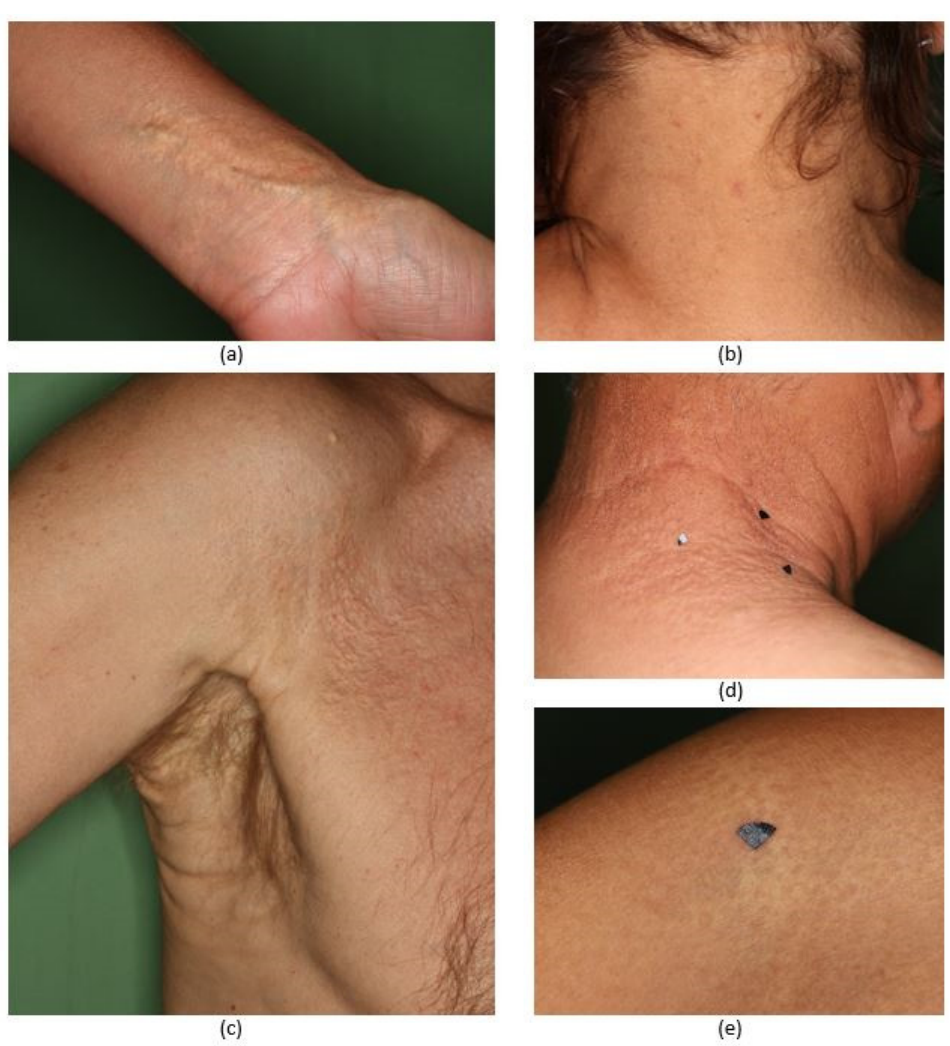
Figure 1. Clinical photographs that display the typical cutaneous manifestations of the patients with pseudoxanthoma elasticum. ( a ) Patient 1, large coalescent plaques on the wrist ( b ) Patient 2, 1–2 mm yellowish papules on the right side of the neck ( c ) Patient 3, redundant, loose skin in the axilla and 2–5 mm papules on the axilla ( d ) Patient 4, 2–6 mm papules on the right and dorsal side of the neck ( e ) Patient 5, right antecubital fossa, yellow-white flat plaques.